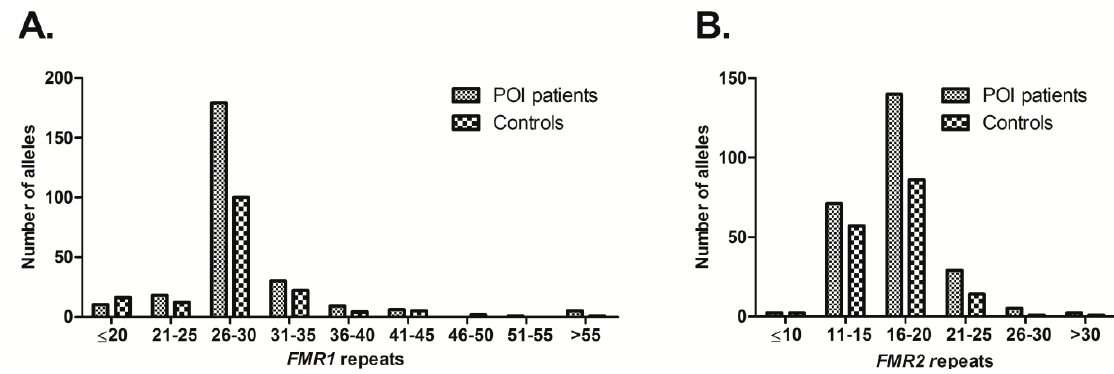
Figure 1. Distribution of the Fragile X Mental Retardation 1 ( FMR1) and FMR2 triplet repeats in primary ovarian insufficiency (POI) patients and controls; ( A ) Repeat distribution for the FMR1 gene. The modal number of CGG repeats was 30 (patients 91/258, controls 64/162), followed by 29 (patients 83/258, controls 35/162); ( B ) Repeat distribution for the FMR2 gene. The most frequent number of repeats was 15 among patients (53/245) as well as among controls (51/161), followed by 18 (patients 50/245, controls 29/161). Only non-related alleles were considered. Table 1. Percentage of primary ovarian insufficiency (POI) patients and controls with intermediate- and premutation-size Fragile X Mental Retardation 1 ( FMR1 ) alleles. Range of Intermediate